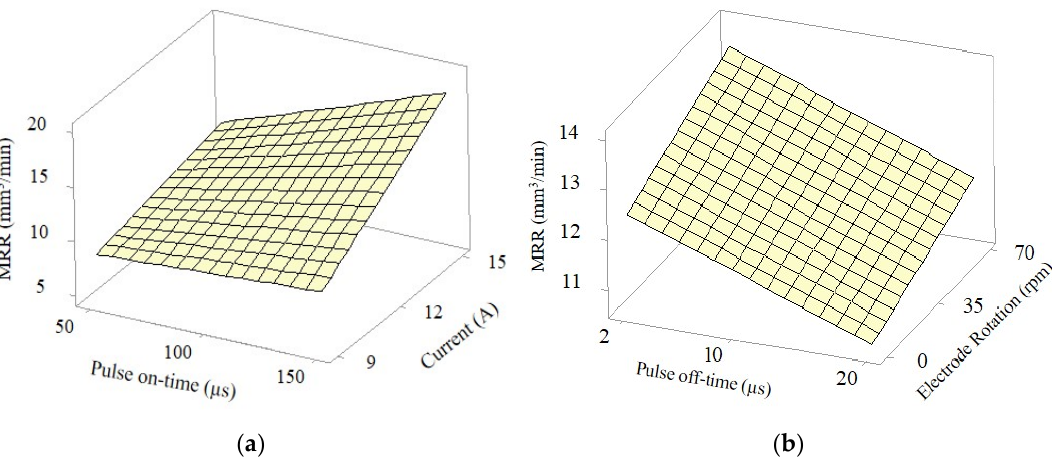
Figure 5. MRR mf as a function of ( a ) pulse on-time and current, given pulse off-time = 10 µs and electrode rotation = 35 rpm, ( b ) pulse off-time and electrode rotation, given pulse on-time = 100 µs and current = 12 A.